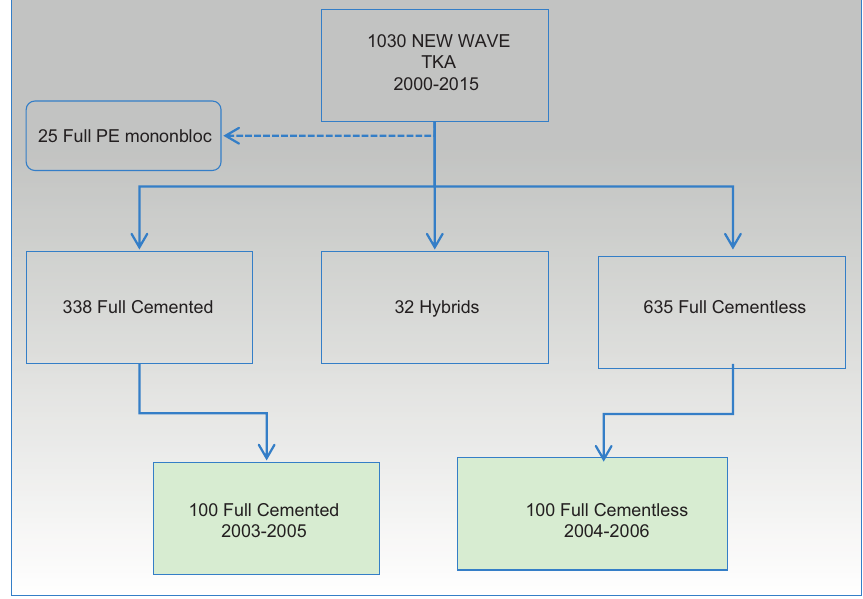
Figure 4. Flow chart of the cases selection.